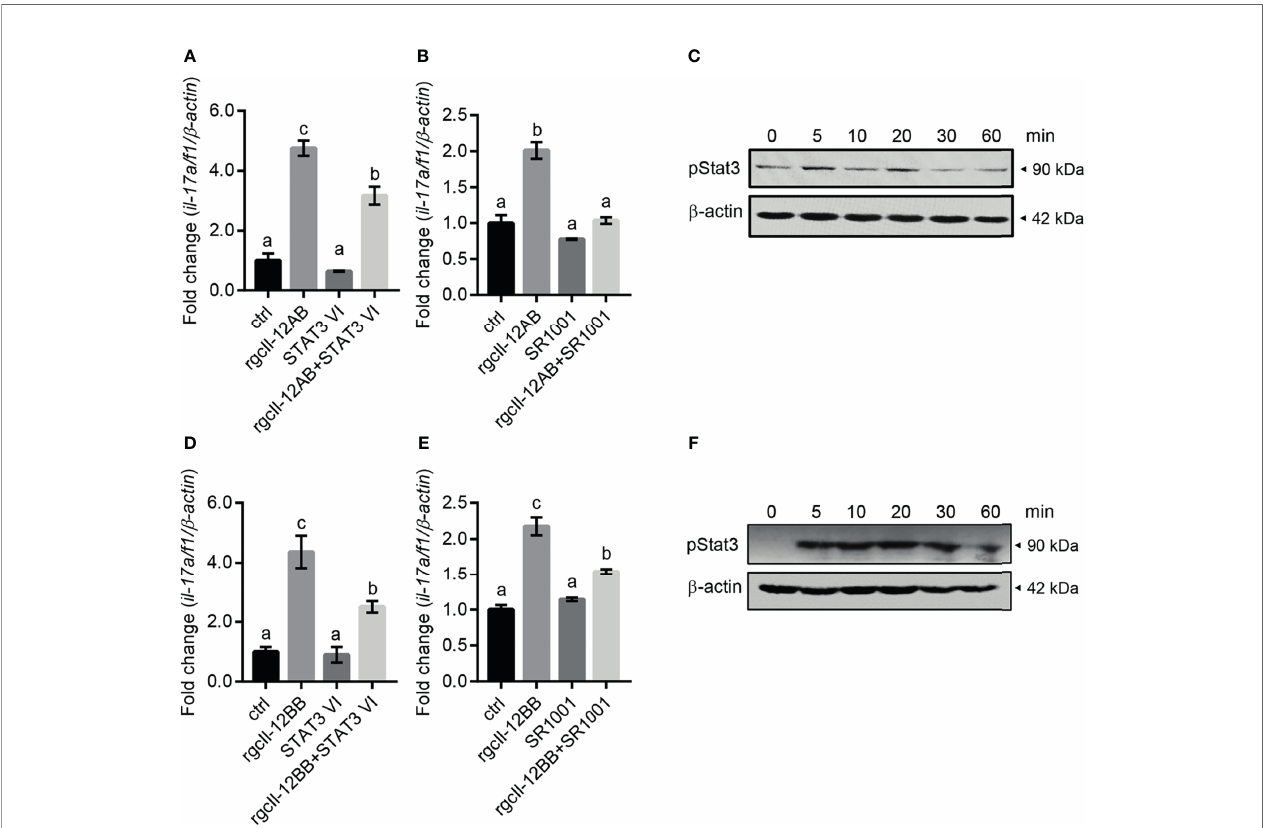
FIGURE 8 | Signaling pathways of rgcIl-12 isoforms in regulating il-17a/f1 in lymphocytes. (A) Lymphocytes were incubated with rgcIl-12AB (1000 ng/mL) in the presence or absence of STAT3 VI (STAT3 inhibitor, 30 µM). (B) Lymphocytes were incubated with RgcIl-12AB (1000 ng/mL) in the presence or absence of SR1001 (ROR g t inhibitor, 15 µM). The il-17a/f1 mRNA was normalized by b -actin and expressed as fold changes compared with the control group. (C) Phosphorylation of Stat3 was detected in the lymphocytes treated with rgcIl-12AB (1000 ng/mL) for 0-60 min. (D) Lymphocytes were incubated with rgcIl-12BB (1000 ng/mL) in the presence or absence of STAT3 VI (STAT3 inhibitor, 30 µM). (E) Lymphocytes were incubated with rgcIl-12BB (1000 ng/mL) in the presence or absence of SR1001 (ROR g t inhibitor, 15 µM). The il-17a/f1 mRNA was normalized by b -actin and expressed as fold changes compared with the control group. Data are shown as mean ± SEM (N = 4). Different letters indicate signi fi cant differences at p < 0.05. (F) Phosphorylation of Stat3 was detected in lymphocytes treated with rgcIl-12BB (1000 ng/mL) for 0-60